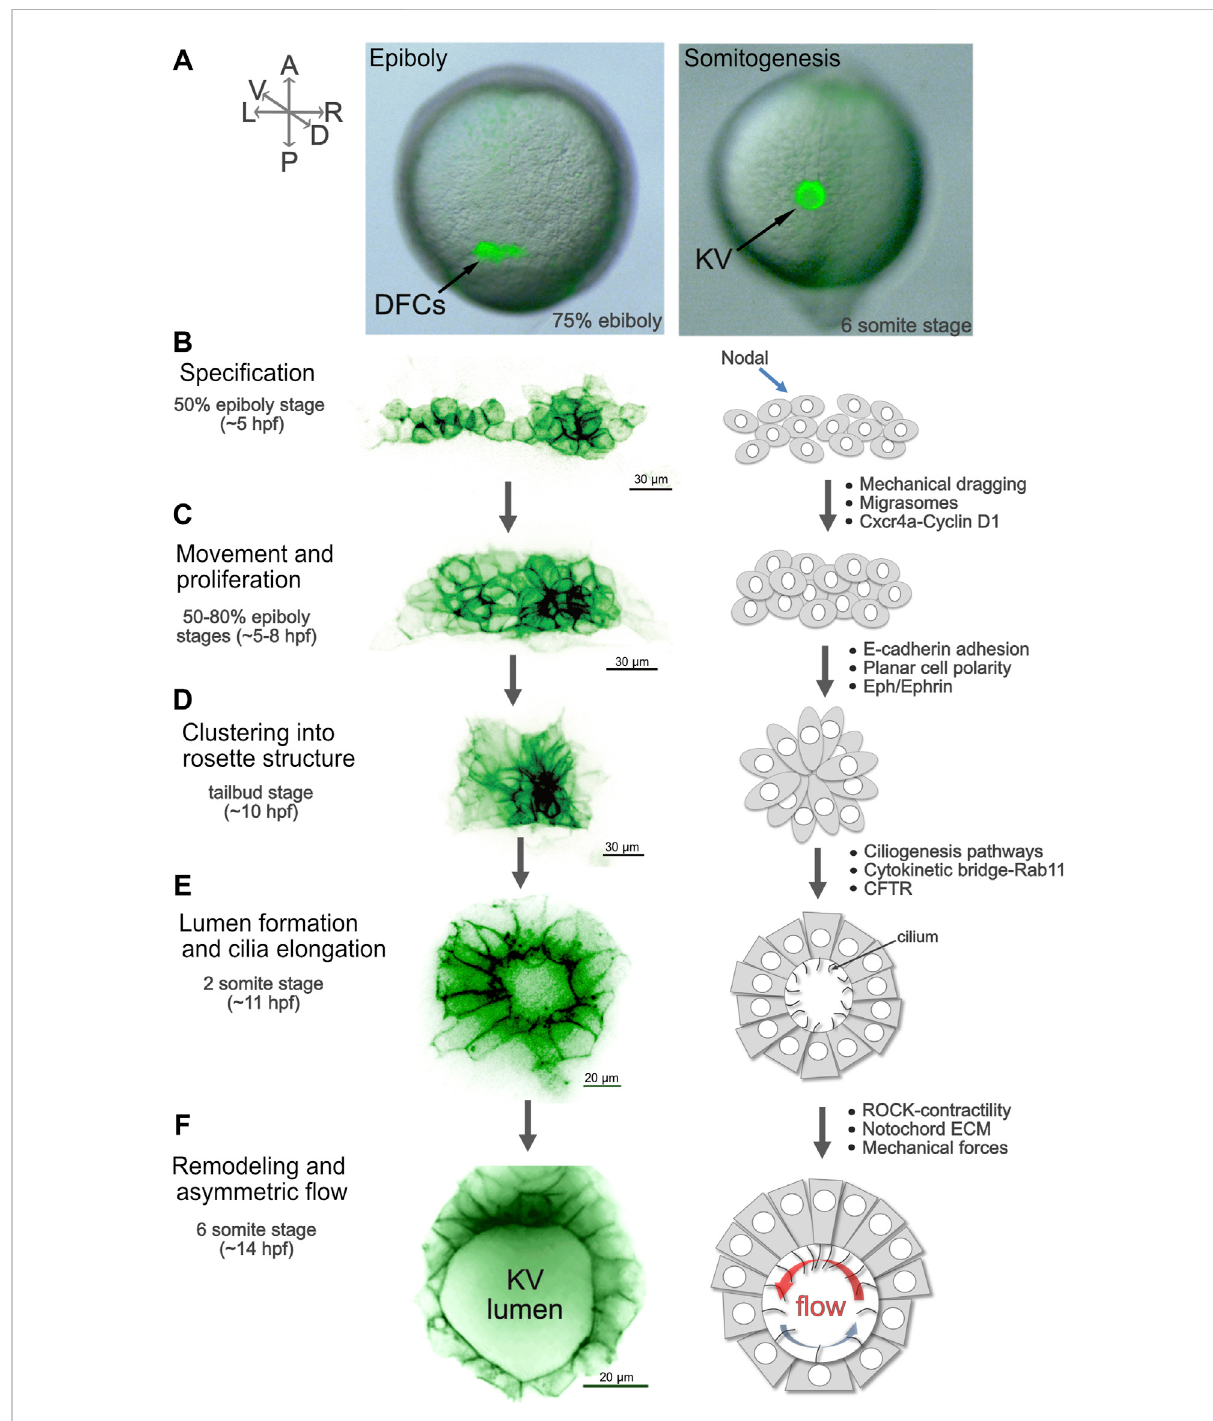
FIGURE 5 Steps of Kupffer ’ s vesicle morphogenesis. (A) Live images of Tg ( sox17:GFP ) (Chung and Stainier 2008) embryos that express GFP (green) in dorsal forerunner cells (DFCs) and Kupffer ’ s vesicle (KV) show the location of these cells in the zebra fi sh embryo during epiboly and early somitogenesis. The GFP signal is superimposed on a bright fi eld image of the embryo. A = anterior, P = posterior, L = left, R = right, D = dorsal, V = ventral. The orientation of the axes shown in (A) applies to all images (A – F) . (B – F) High-resolution snapshots of DFCs and KV cells in live Tg(sox17:EGFP-CAAX) (Dasgupta et al., 2018) embryos expressing membrane-localized GFP (shown using an inverted thalium lookup table) alongside simpli fi ed diagrams of cell morphologies that represent speci fi c steps of DFC/KV development. Examples of mechanisms that regulate each step are listed (see main text for details). (B) Approximately 20 – 30 mesenchymal DFCs are speci fi ed at the 50% epiboly stage. (C) DFCs move